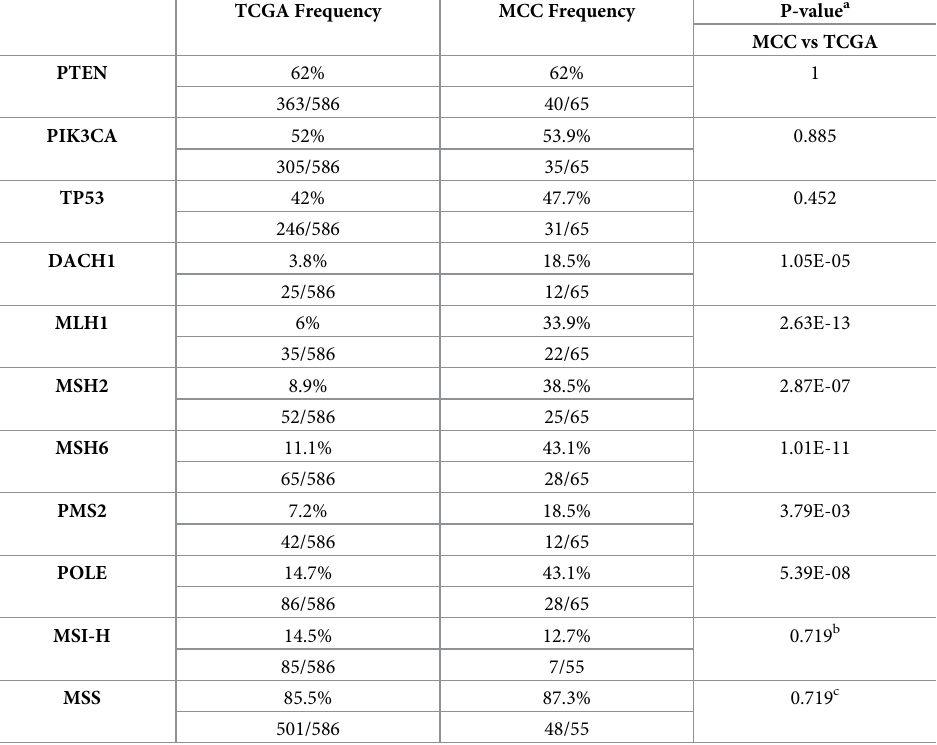
Table 5. Comparison of mutation frequency in endometrial cancer and carcinosarcoma between MCC and TCGA PanCancer Atlas (PCA).